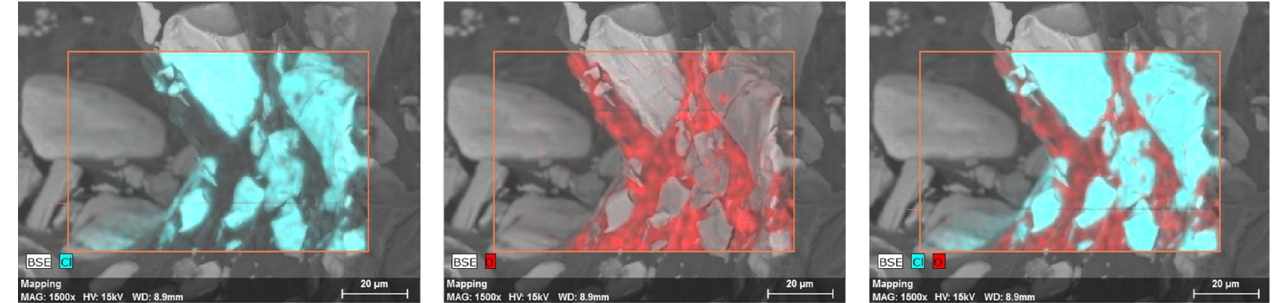
Figure 4. The chemical element analysis of V3 showed the API in solid crystal form (chlorine-con- taining elements are marked in blue) and separated from the matrix (oxygen-containing elements are marked in red). It accumulated on the inner surfaces of cavities.